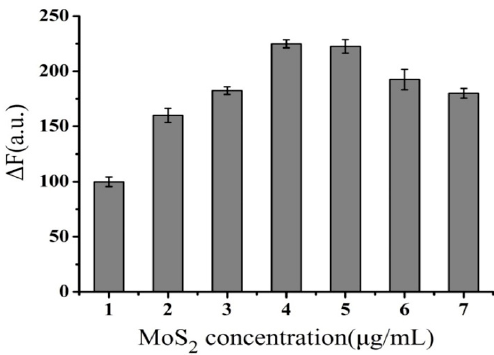
Figure 2. Dependence of the relative fluorescence change ( ∆ F = F 1 − F 2 ) on different concentrations of MoS 2 nanosheets. Error bars represent the standard deviation of three experiments.